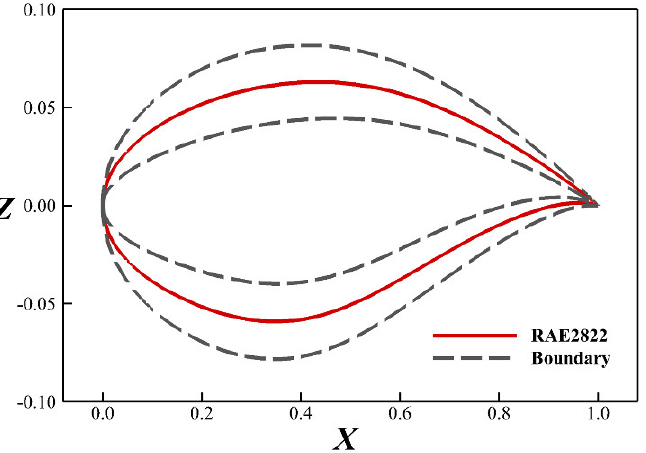
Figure 2. Geometry of the baseline airfoil and the shape deformation boundary for dataset prepara- tion.